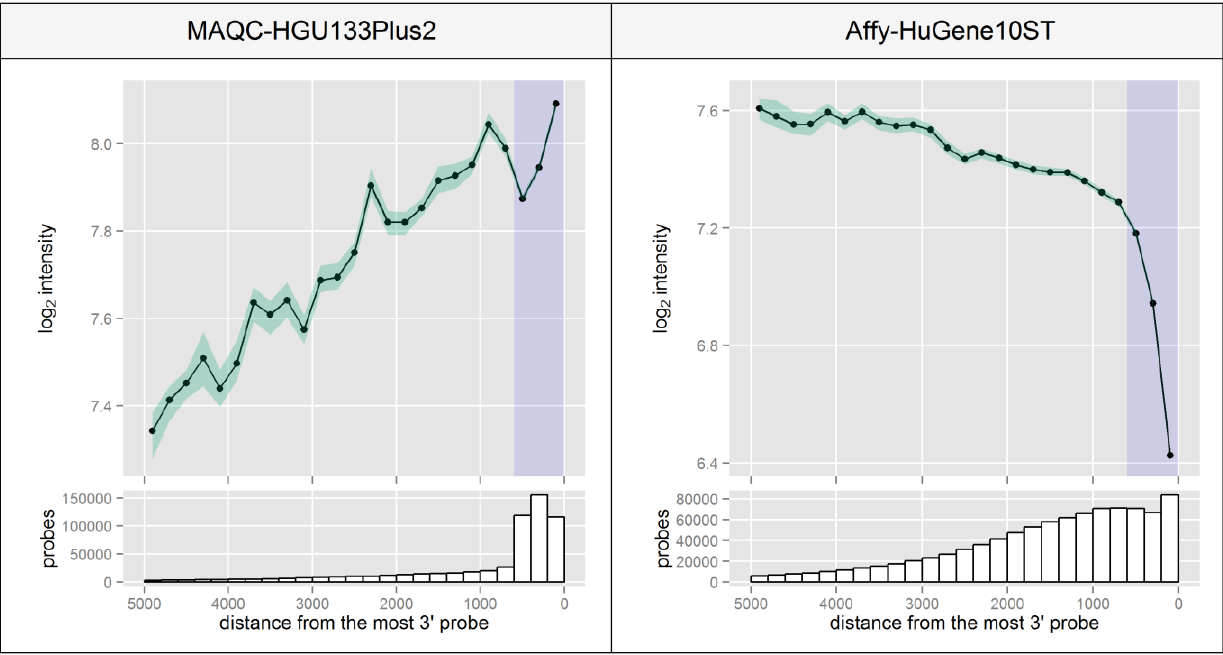
Figure 5. Median and 95% CI of probe intensities relative to the distance of the most 3' probe in a probeset, calculated for probes in 200nt-long sequence regions. Blue color indicates the 600 bp region defined by the manufacturer as the maximum distance between probes in a single probeset for 3'IVT type microarrays like the HG-U133_Plus_2. Bar plots in the lower panel represent the number of probes which are located at a specific distance from the most 3'